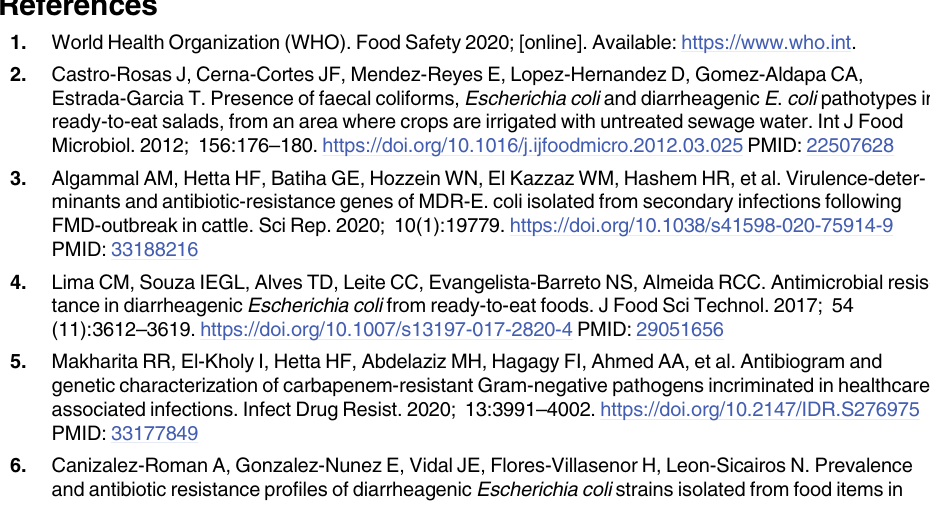
S1 File. Supplementary tables. S1 Table. PCR primers used in this study for E . coli